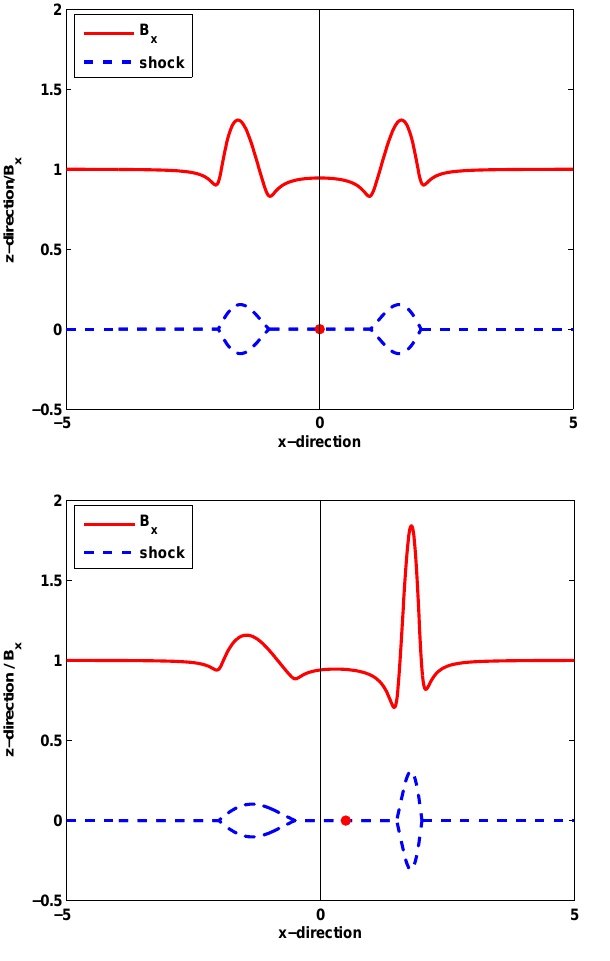
Fig. 8. Behavior of the magnetic field x-component in the inflow region. In the upper panel, the assumption U = 0 holds, whereas in the lower panel, the case U = 0 . 5 v A is shown. Both functions are calculated for t = 2. Besides the magnetic field strength, the actual positions of the field reversal regions are shown. The dot represents the final position of the reconnection line again. B x is blown up by the factor 10 for a better visibility.